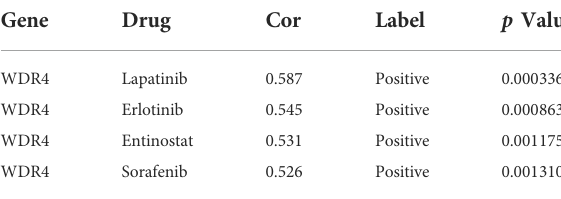
TABLE 2 Four most correlated anticancer drugs screened from the GDSC